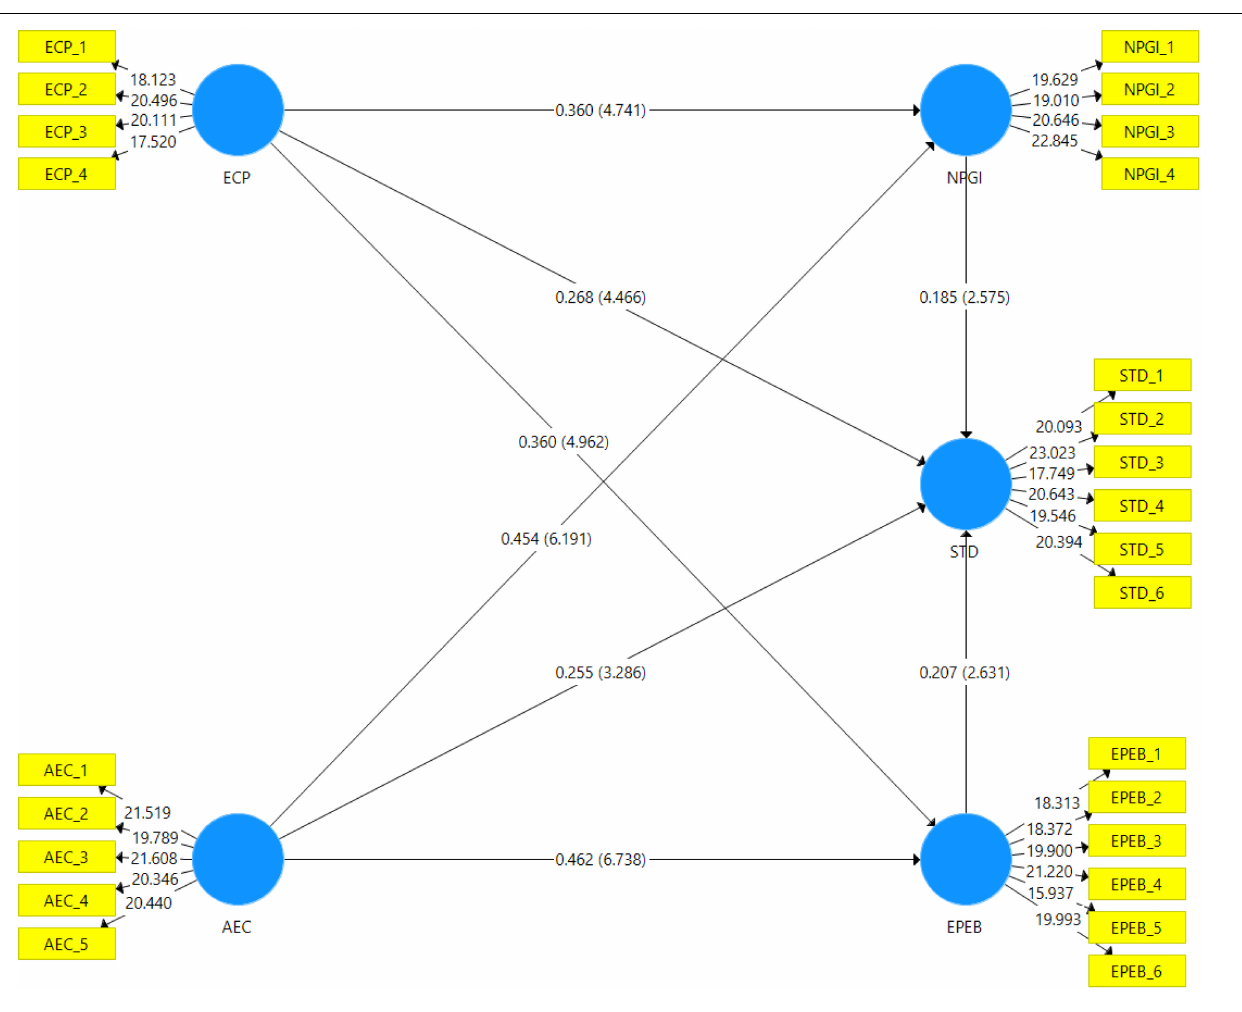
Figure 3 is a graphical representation of the structural